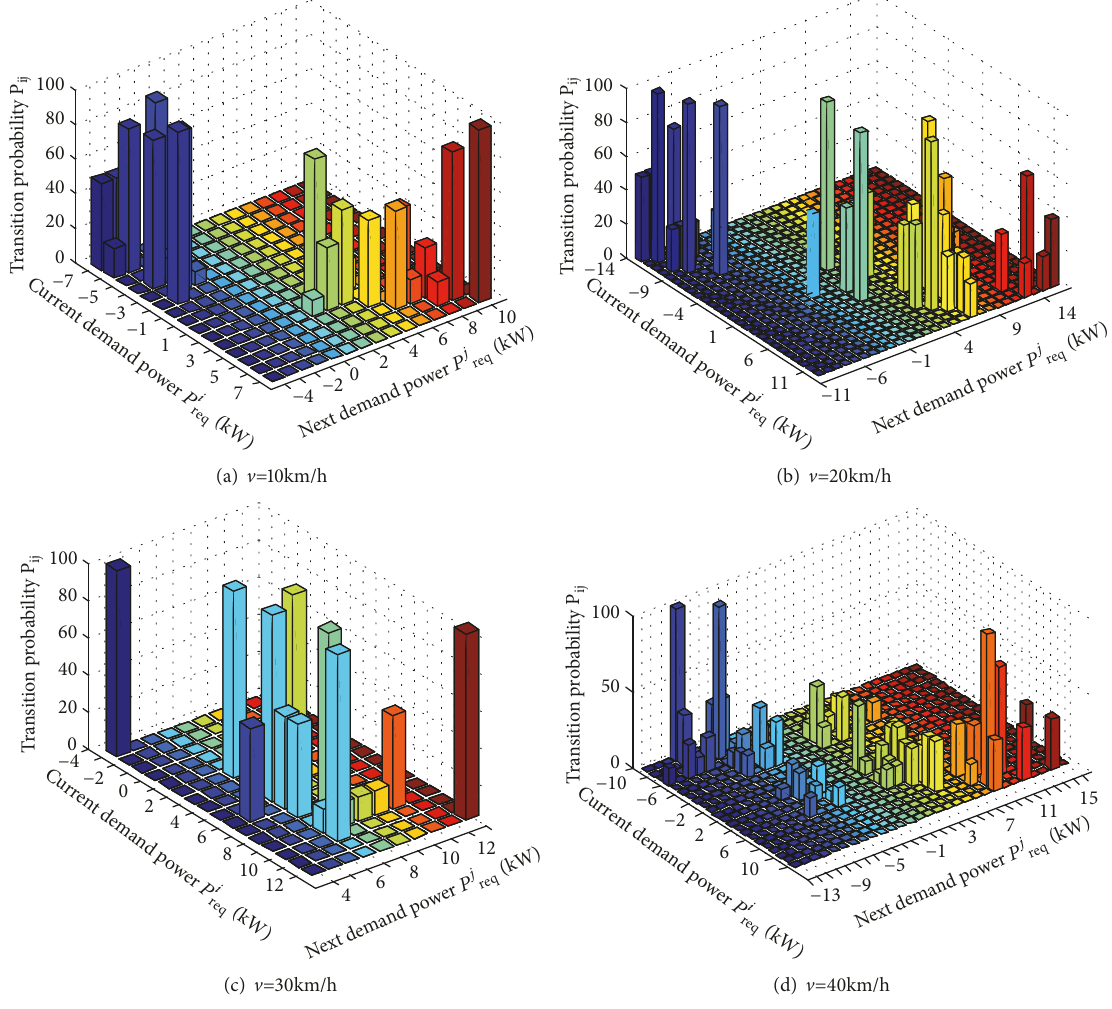
Figure 6: Power demand transition probability matrix.